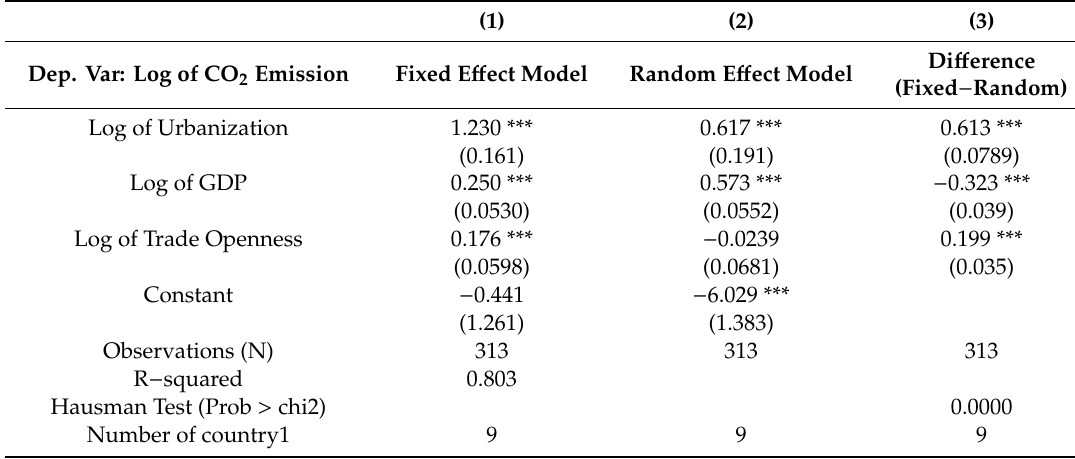
Table 1. Comparison of fixed and random e ff ect models.